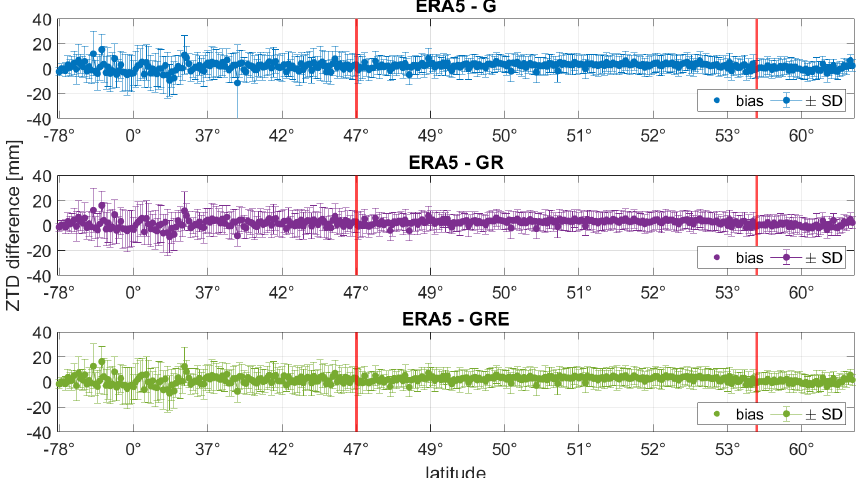
Figure 6. The ZTD biases and SDs for each station (sorted by latitude, Southern Hemisphere first) between the ERA5 model and three different GNSS solutions. The red lines indicate the latitude band that includes Germany. Please note that the labeling of the x axis is non-equidistant. The statistics are calculated for the year